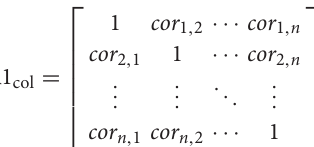
columns and field